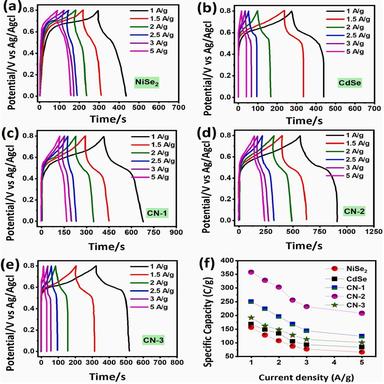
Discharge/charge characteristics of the electrodes, (a) NiSe2, (b) CdSe, (c) CN-1, (d) CN-2, (e) CN-3 composite, (f) current against Specific capacity (C/g) plot of all electrodes.